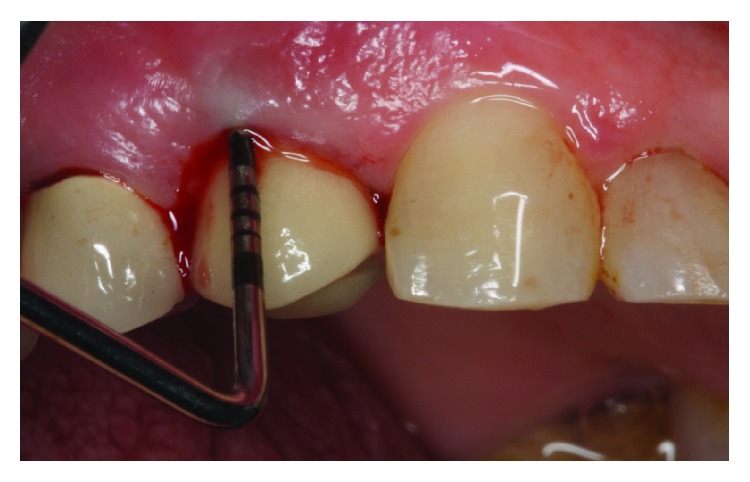
Bleeding on probing.